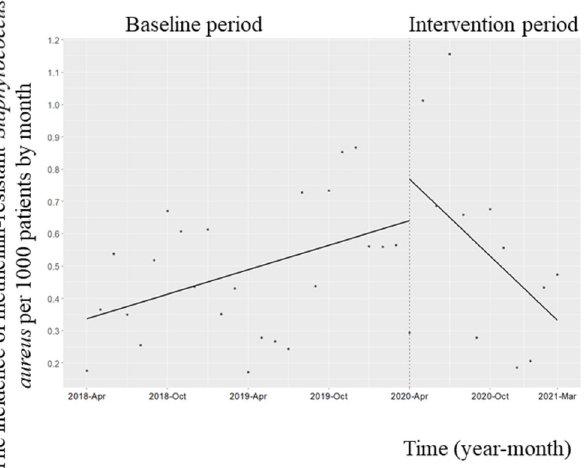
Fig 5. Trends in the incidence of methicillin-resistant Staphylococcus aureus (MRSA) per 1000 patients, by month, during Phase 2 of the intervention period. Each dot refers to the incidence of MRSA per 1000 patients each month and the slope is based on linear regression in the two phases. The explanation of each phase is as follows: Phase 1 (antimicrobial notification by the infection control team from April 1, 2018, to March 31, 2020); Phase 2 (establishing an infectious disease [ID] consultation service and implementation of the Antimicrobial Stewardship Program [ASP] from April 1, 2020, to March 31, 2021). The number of isolated samples in 2018, 2019, and 2020 was 61, 72, and 69, respectively. The level of the monthly incidence of MRSA did not decrease (coefficient: 0.12; 95% confidence interval [CI]: − 0.16 to 0.42, p = 0.40), although there was a significant reduction in the trend of the infection (coefficient: − 0.05; 95% CI: − 0.09 to − 0.013, p = 0.01).